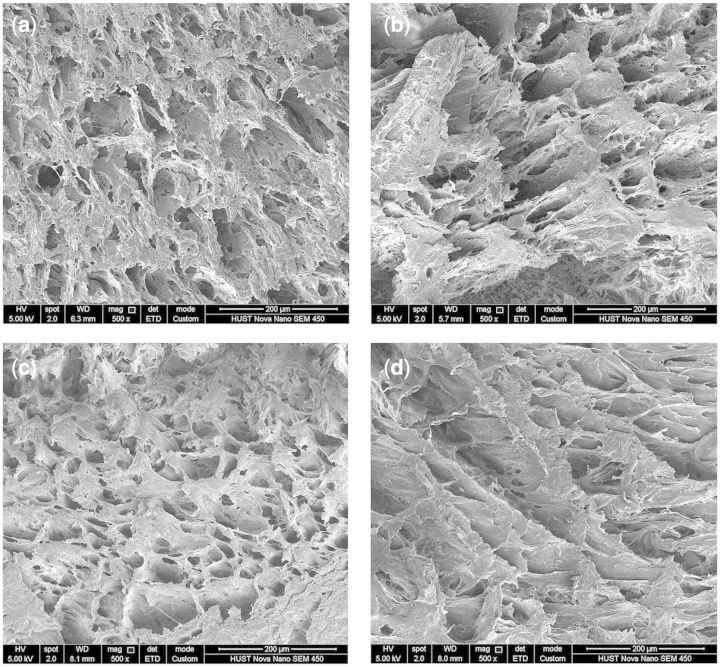
SEM images of the cross sections of SF/PVA blend scaffolds with different weight ratio (a) 5:5, (b) 4:6, (c) 3:7 and (d) 2:8